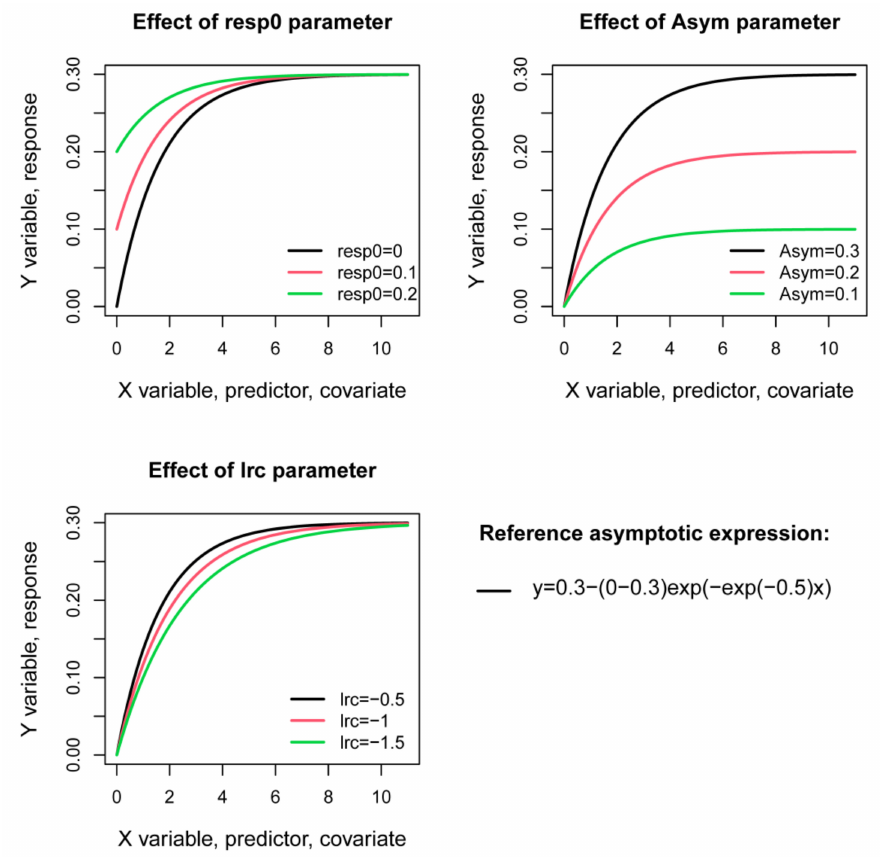
Figure 8. Role of the parameters within the nonlinear asymptotic regression